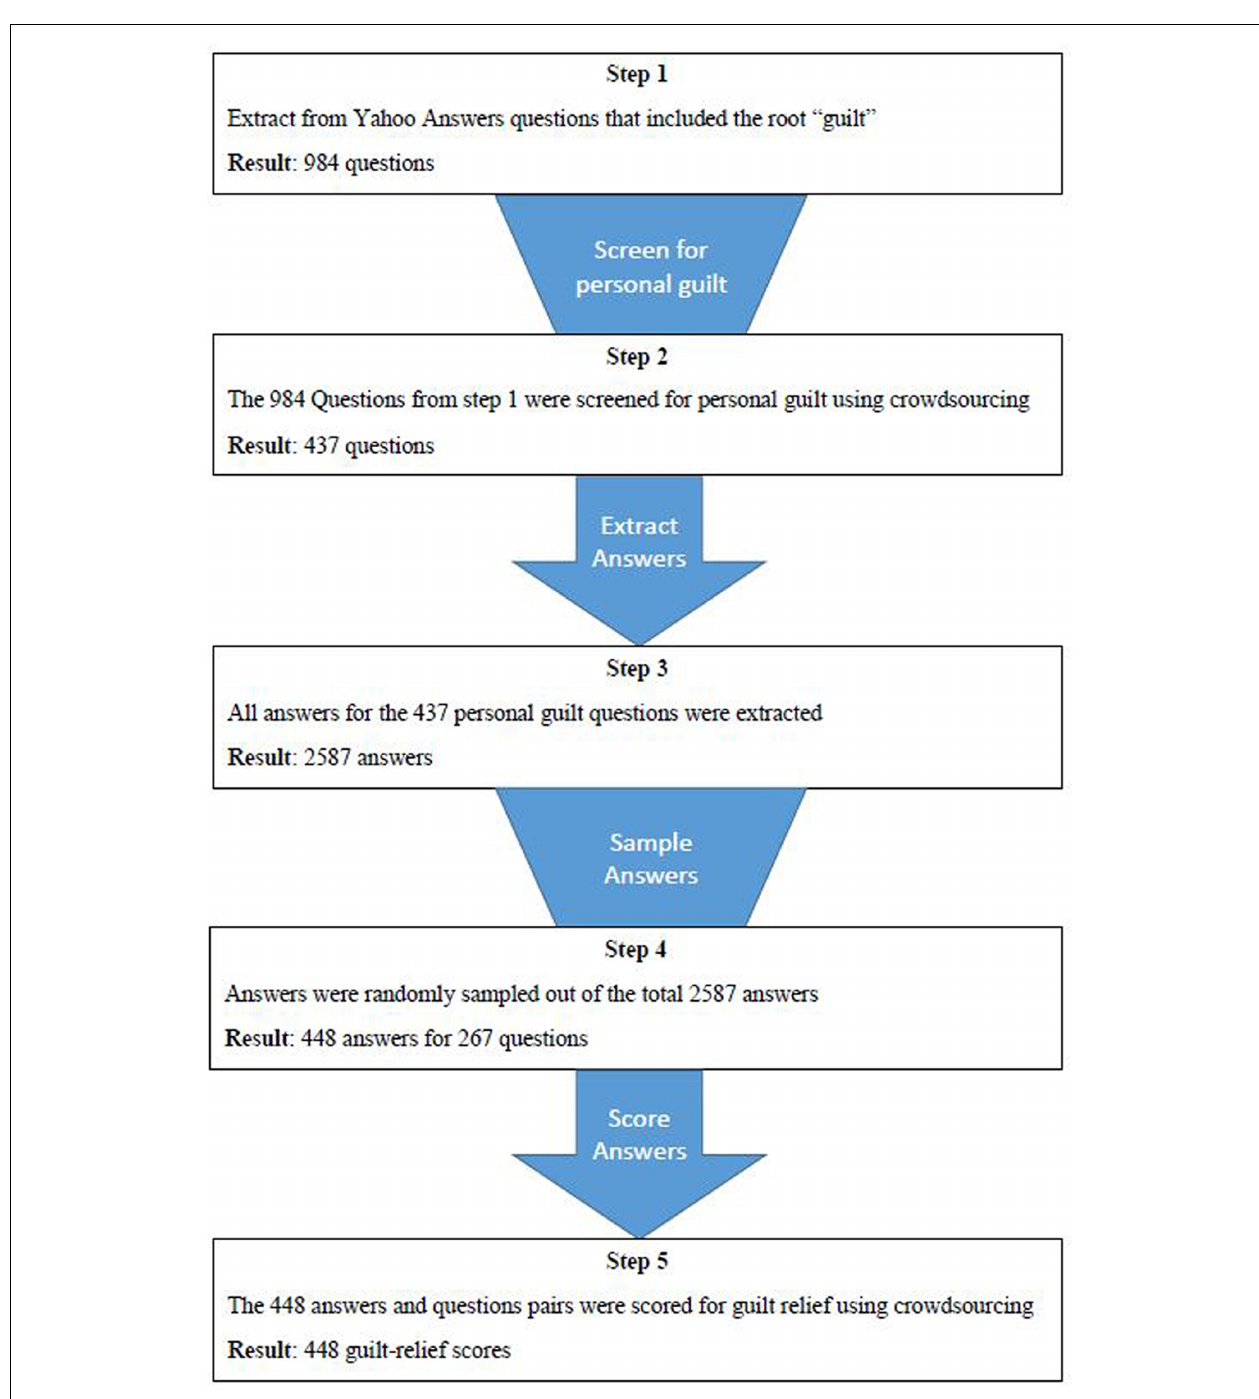
FIGURE 1 | A flow chart of the steps in data set